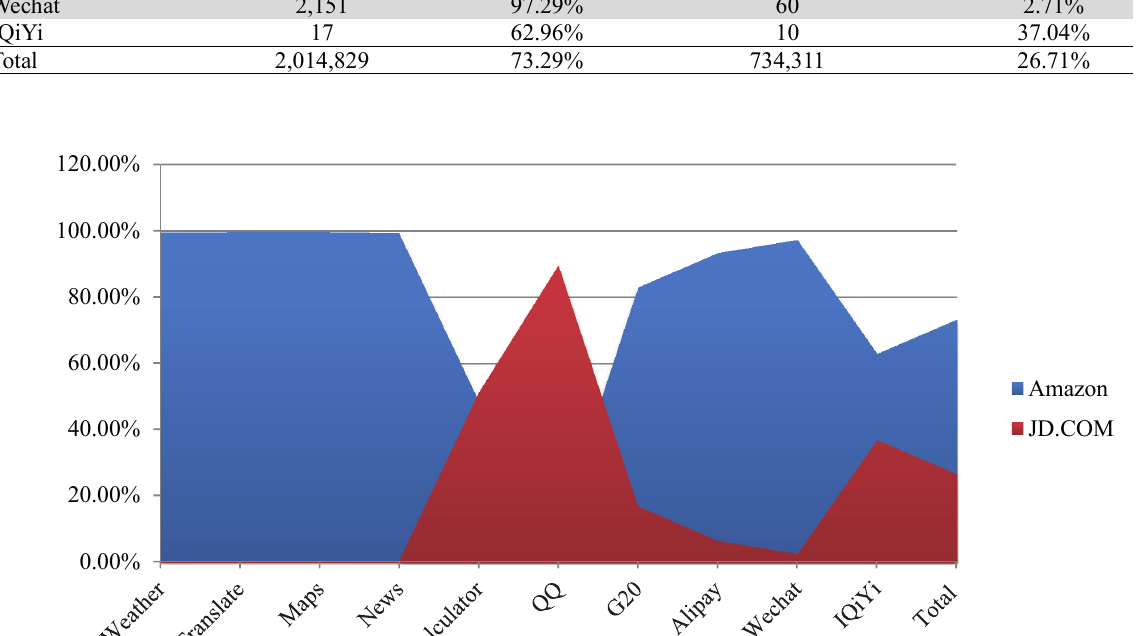
Fig. 10. Comparison of Relative Recall in Amazon and JD.COM